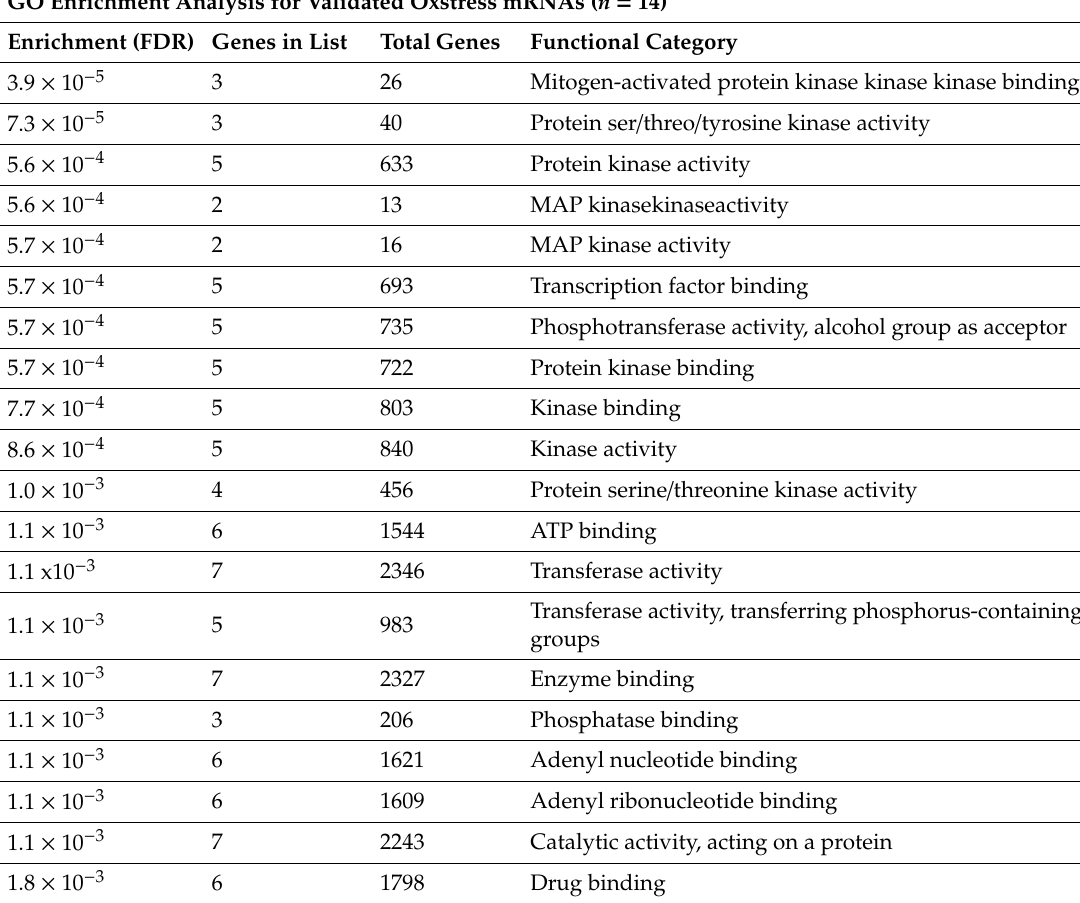
Table 3. GO Enrichment analysis for Validated Oxstress mRNAs ( n = 14). Shown are the first 20 Functional Categories at the “GO molecular function” section. Enrichment FDR shows the